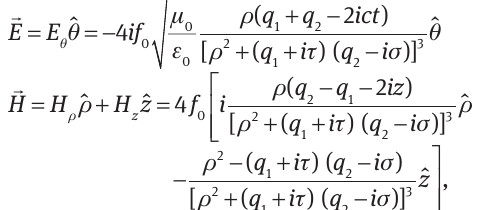
(cid:31) simple properties of the pulse, such as interactions with dielectric and metallic interfaces, can be nontrivial [14]. In particular, while the fields of the TE pulse retain their ori- (cid:31) entation relative to the propagation direction upon reflec- tion, this is not true for the TM pulse. The latter acquires a longitudinal field antiparallel to its propagation direction when it is reflected from a perfect electric conductor or a dielectric interface. These field transformations are direct consequence of the boundary conditions at the interface where σ = z + ct , τ = z − ct , and q , q play the role of the effec- 1 2 in combination with the complex topology of the pulse. tive wavelength and Rayleigh range, respectively. In par- ticular, the value of the ratio q / q indicates whether the 2 1 > > 1) or strongly focused. The elec- pulse is collimated ( q / q 2 1 tric field is azimuthally polarized with no longitudinal or radial components, whereas the magnetic field is oriented along the radial and longitudinal directions with no azi- muthal component (see Figure 1A). The TM FD pulse can be obtained by an exchange of electric and magnetic fields [2]. From the complex electromagnetic fields of Eq. (1), two dif- ferent pulses can be constructed corresponding to the real and imaginary parts of the fields, respectively. Both types of pulses are exact solutions to Maxwell’s equations. The real part corresponds to a pulse, which is single-cycle in the electric field and 1½-cycle in the magnetic field, whereas the imaginary part leads to a pulse, which is 1½-cycle in the electric field and single-cycle in the magnetic field. We refer to the real part as the single-cycle pulse and to the imagi- nary part as the 1½-cycle pulse. Upon propagation, single- cycle (1½-cycle) transforms to the 1½-cycle (single-cycle) pulse due to the Gouy phase shift [13]. The presence of both longitudinal and transverse field components has led to suggestions for applications, such as charged particle acceleration [2], whereas even